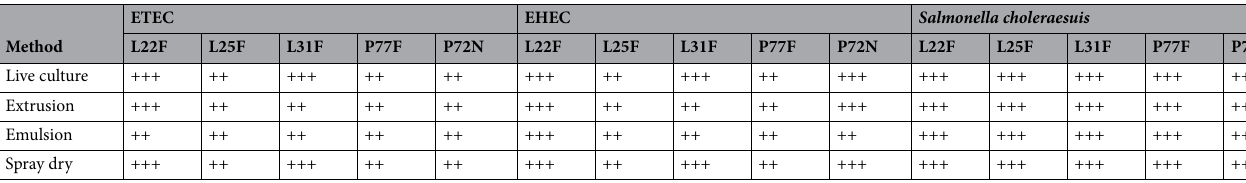
Table 3. Antibacterial activity of the cell free supernatant (CFS)* of live-cultured and 6-month stored encapsulated LAB. *Non-neutralized CFS; The diameters of the inhibition zones were measured and interpreted as (+) weak inhibition (6–9 mm), (++) intermediate inhibition (10–13 mm), (+++) strong inhibition (14–16 mm) and (++++) very strong inhibition (> 17